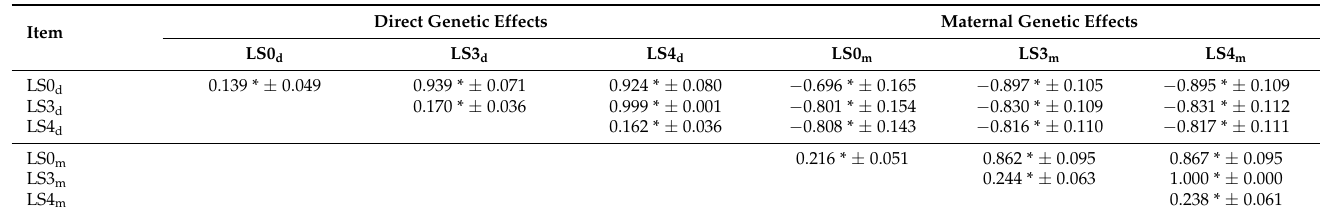
Table 4. Direct and maternal heritability estimates (diagonals), direct–maternal genetic correlations (upper diagonals), and SE (lower diagonals) of sow’s litter size using a three-trait animal model with maternal genetic effects.